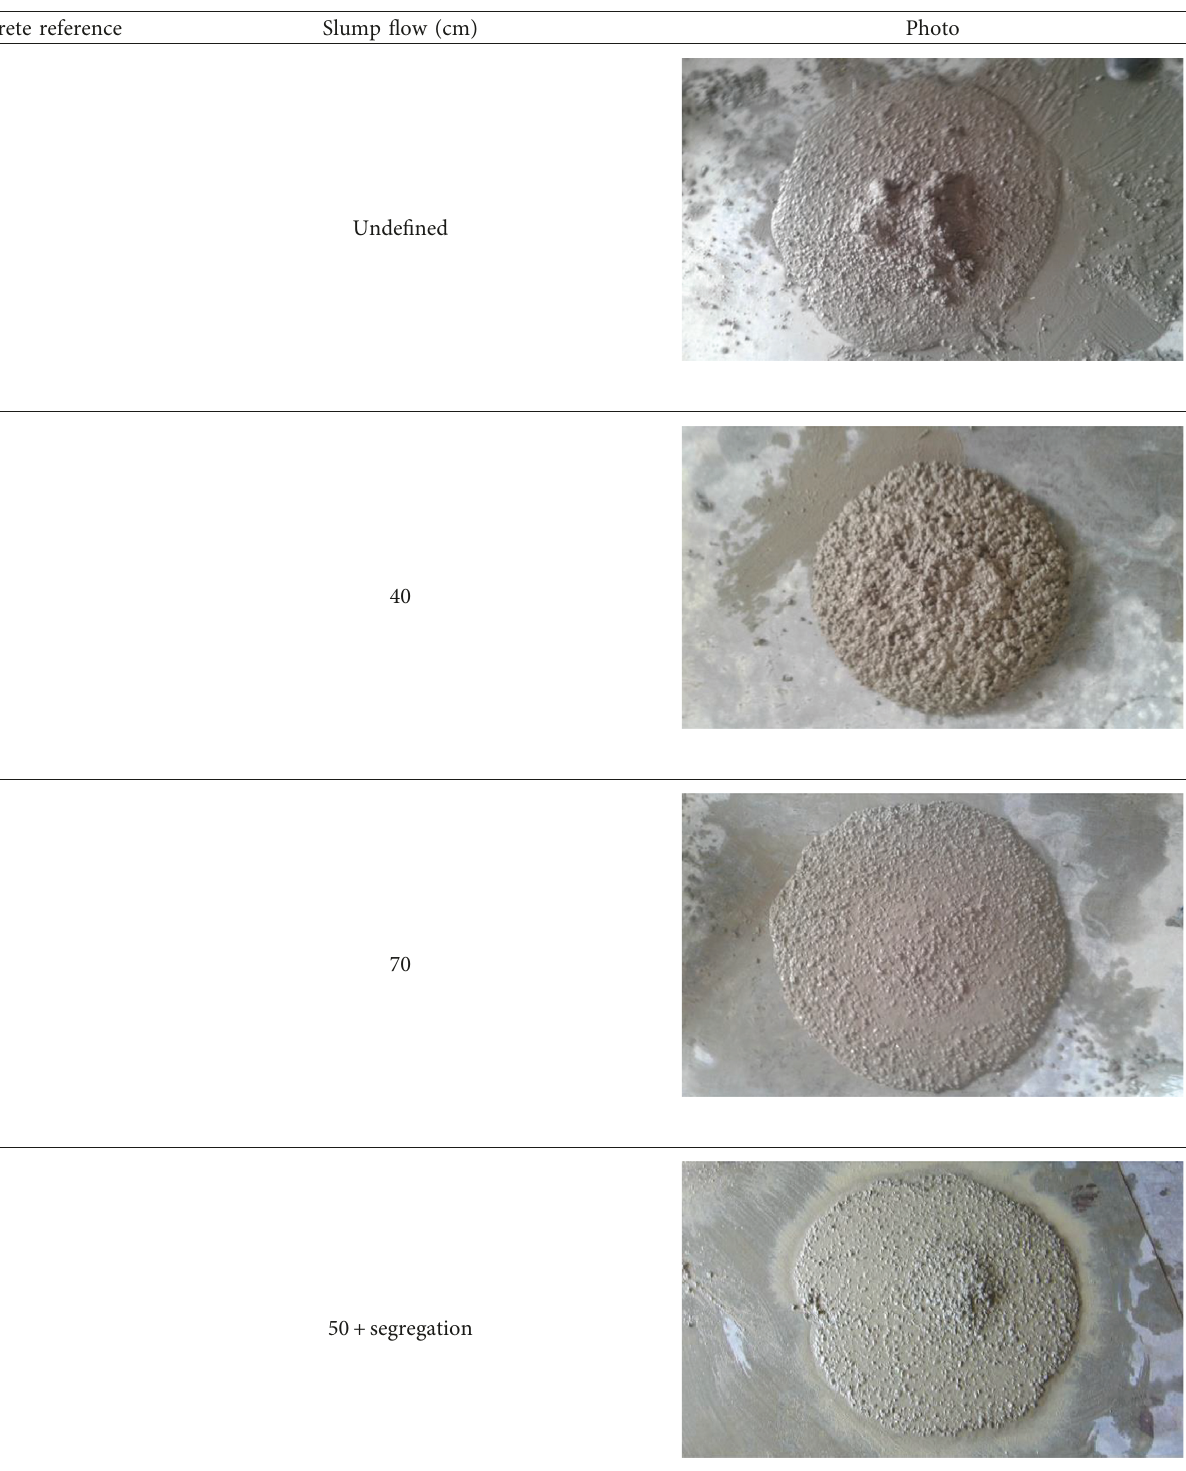
Table 10: Slump flow